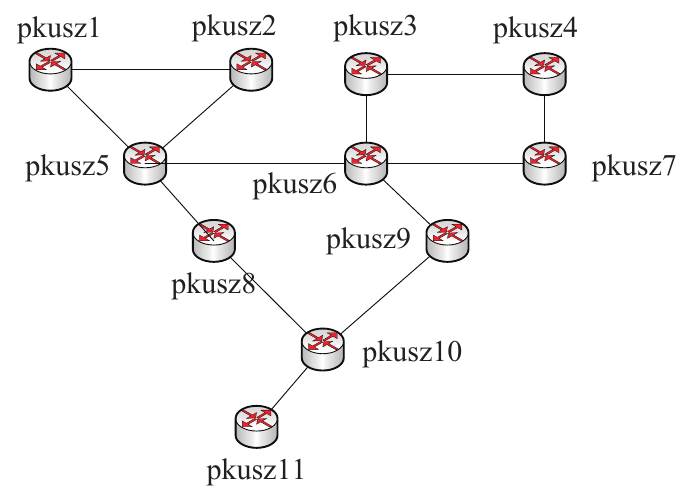
Figure 7. DDESS performance evaluation